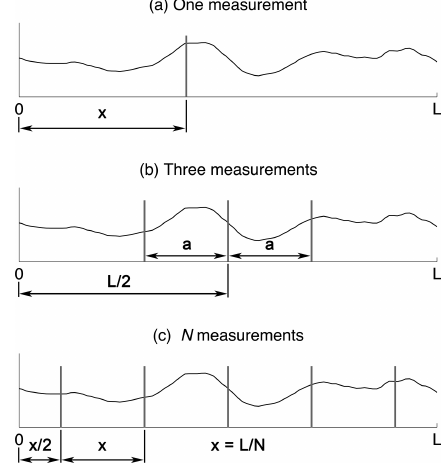
Figure 5. Survey designs for the sampling of a snow profile.